Question: What visual encoding does this figure use to show its data?
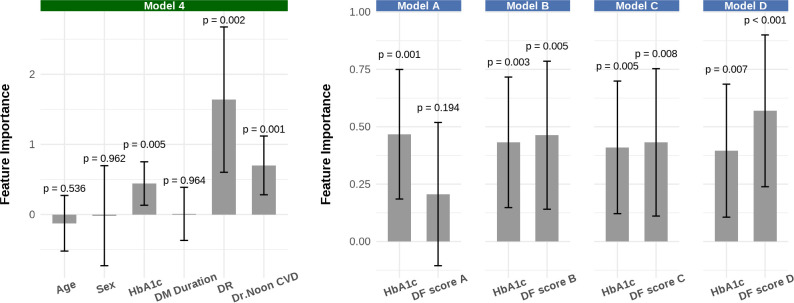
Answer: bar